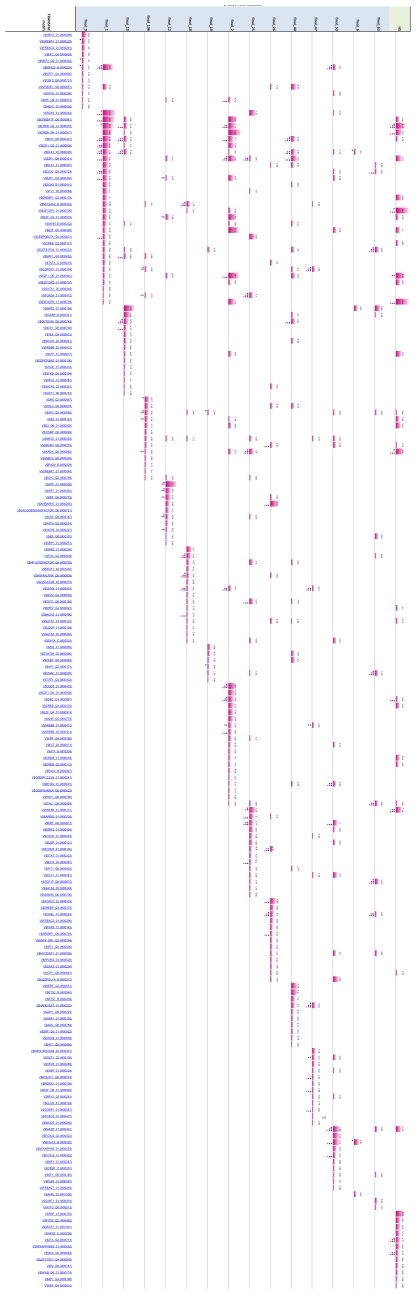
TRANSFAC motif profiles for the fifteen clusters found by correlation clustering (cyan bars).Only “key” regulators of each profile, which are found by hitting set analysis (see figure legend), are shown. The TRANSFAC profile for the set containing all the key regulators' coding genes is shown (orange bars); this profile in effect contains “higher level” regulators – regulators of regulators. Size of bar is proportional to the negative natural logarithm of p-value, which is also given as a number. Only significant motifs (p-value ≤0.05) are shown.